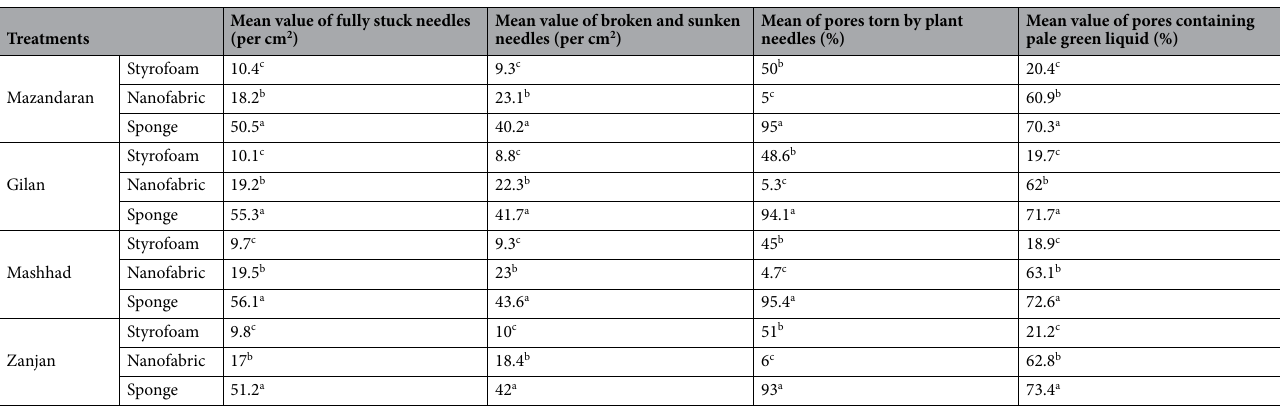
Table 1. Comparison of means for surface effects on four markers of nettle venom collection. Treatments with at least one letter in common showed no significant difference.